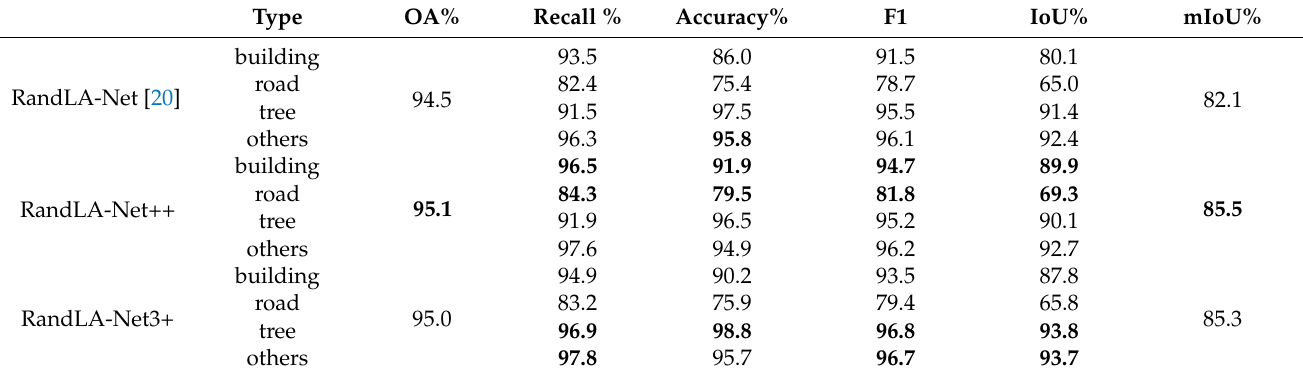
Table 3. Segmentation results evaluated on IoU of each category, mIoU, and OA of the NJSeg-3D dataset. Note: the bold numbers represent the highest score in each